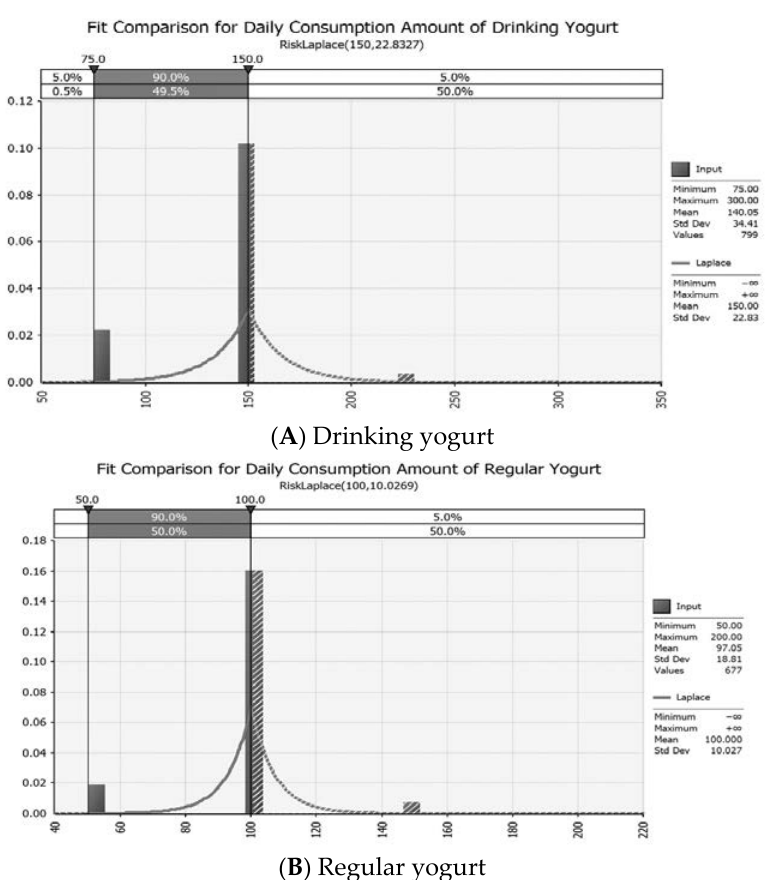
Figure 4. Probabilistic distribution for daily consumption amount of yogurt with @Risk.